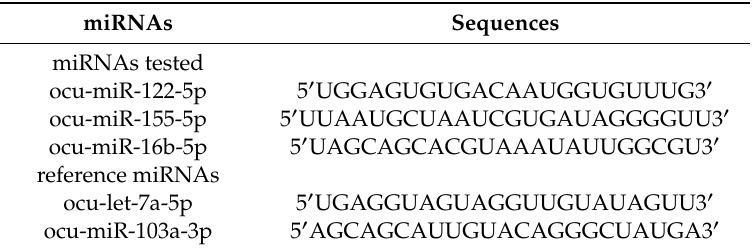
Table 1. Sequences of microRNAs